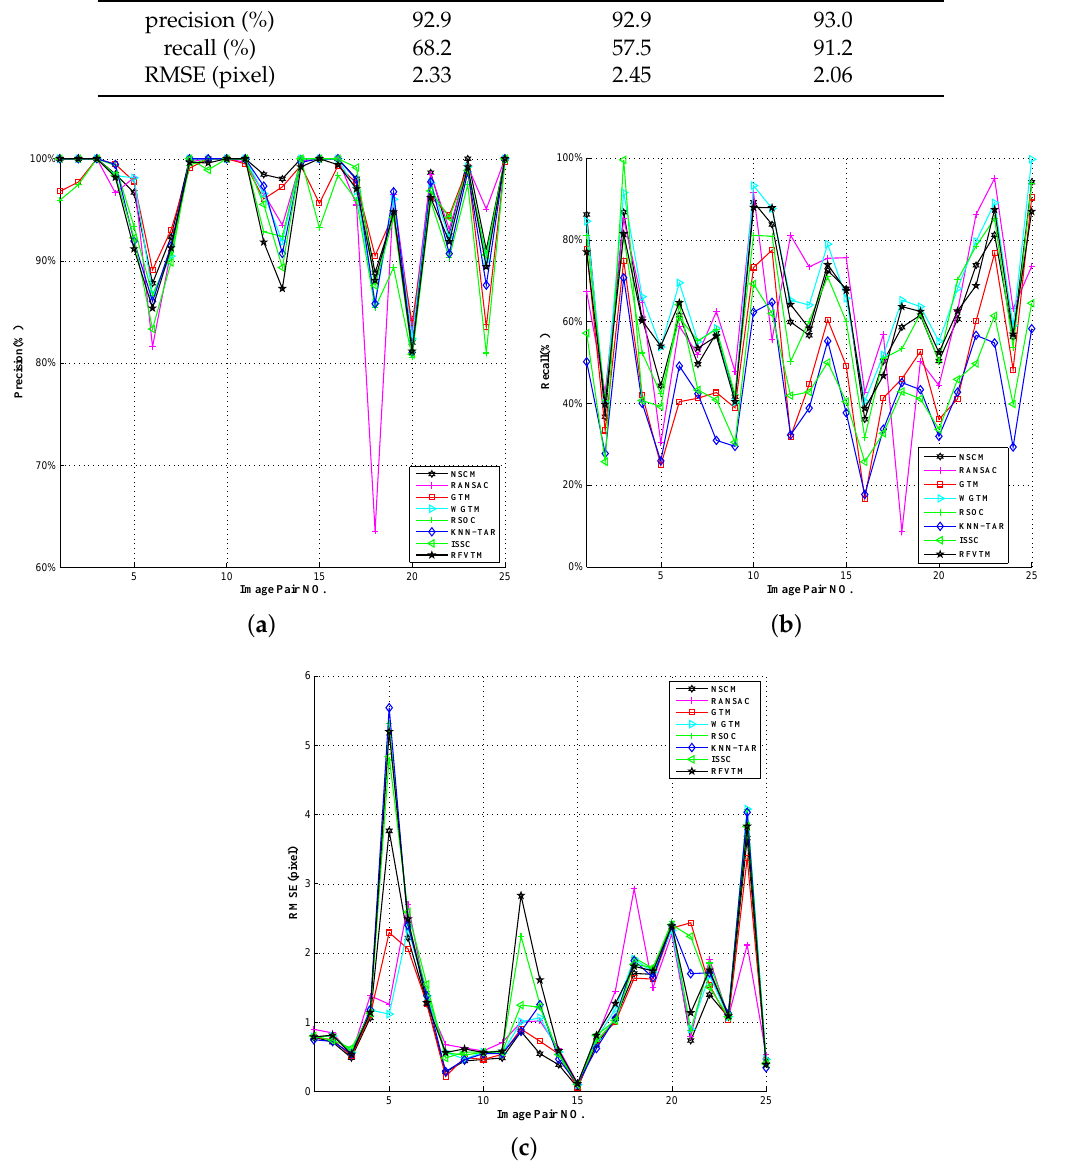
Figure 6. Performance of eight algorithms on 25 images. NSCM is competitive with RANSAC, GTM, WGTM, RSOC, KNN-TAR, ISSC and RFVTM in precision, recall and RMSE. ( a ) precision; ( b ) recall; ( c )